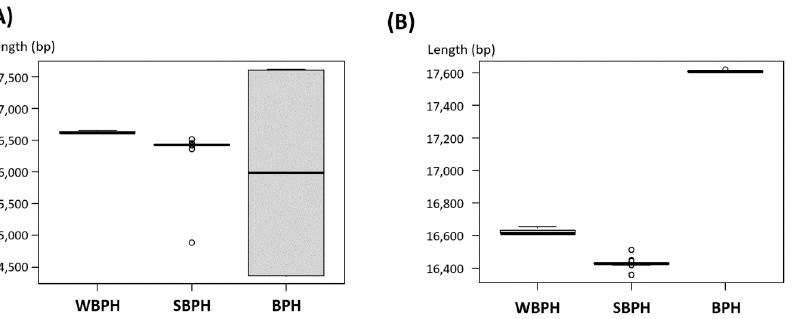
Figure 2. Length variations of the WBPH, SBPH, and BPH complete mitogenomes. ( A ) present the histogram of all available WBPH, SBPH, and BPH complete mitogenomes. The grey-colored box indicates 75 percentile of mitogenome length and the middle line means the median value of mitogenome length. Small circles indicate outliers. ( B ) display the histogram of all available WBPH, SBPH, and BPH mitogenomes except the seven BPH mitogenomes which lack their control regions.